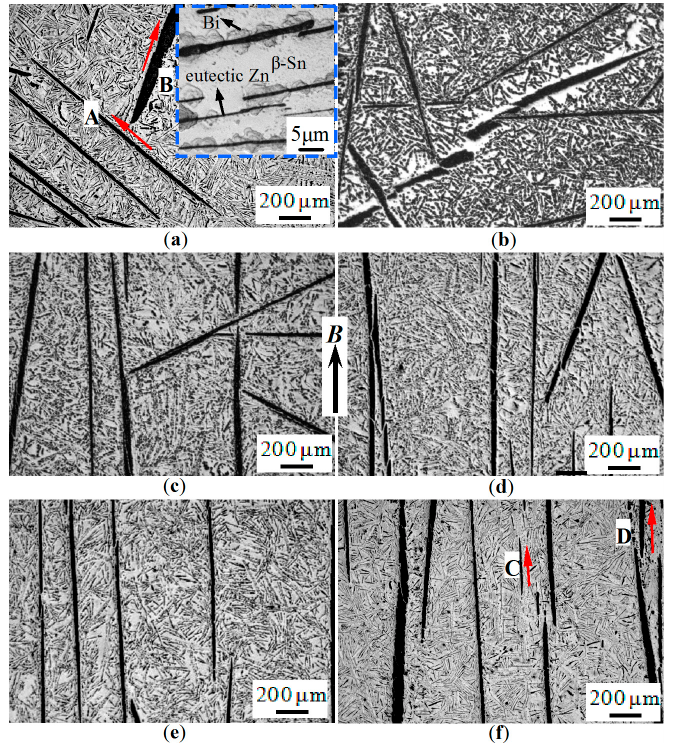
Figure 3. Microstructures corresponding to the central regions of the macrostructures in Figure 2: ( a ) 0, ( b ) 0.6, ( c ) 1.5, ( d ) 3, ( e ) 5, and ( f ) 8.8 T, respectively. The insert in (a) shows the magnified